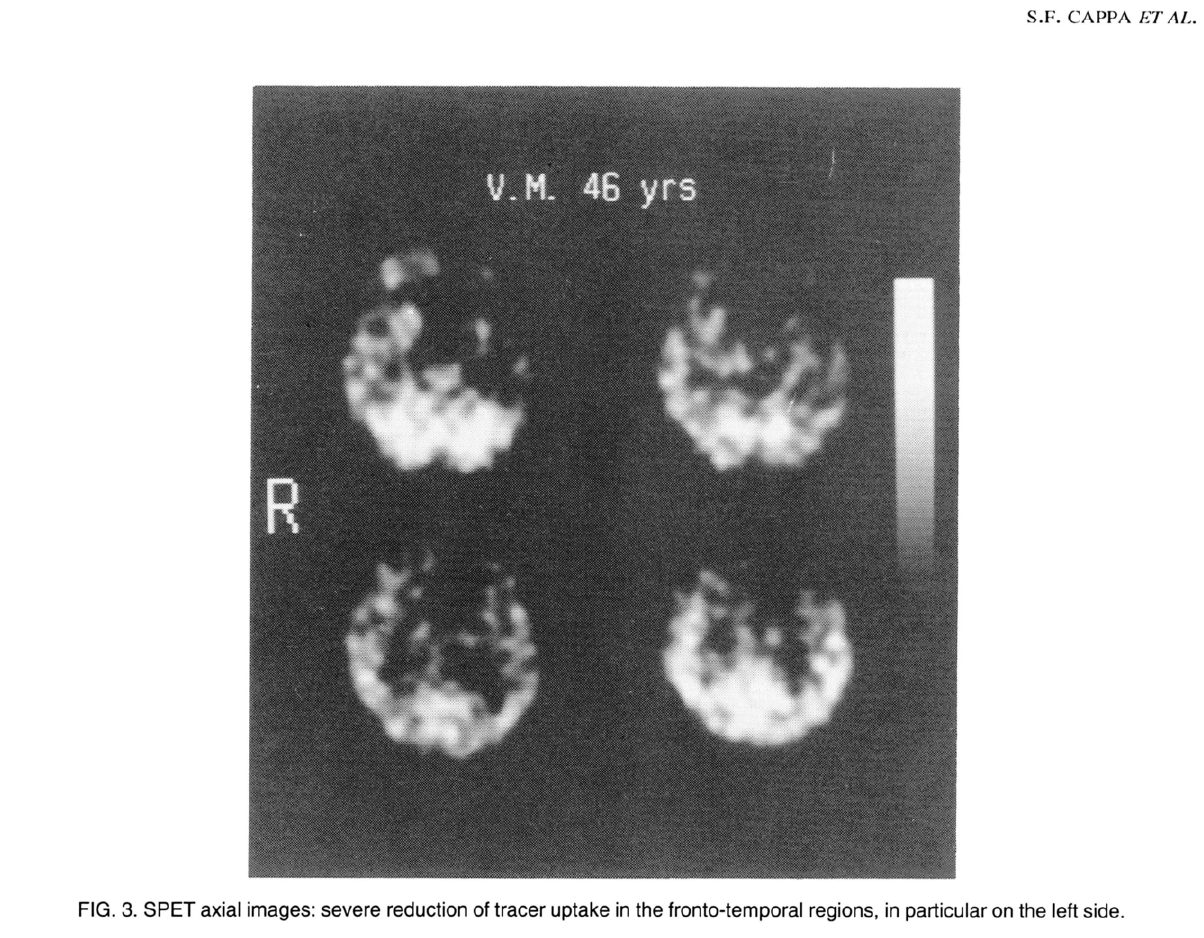
FIG. 3. SPET axial images: severe reduction of tracer uptake in the fronto-temporal regions, in particular on the left side.